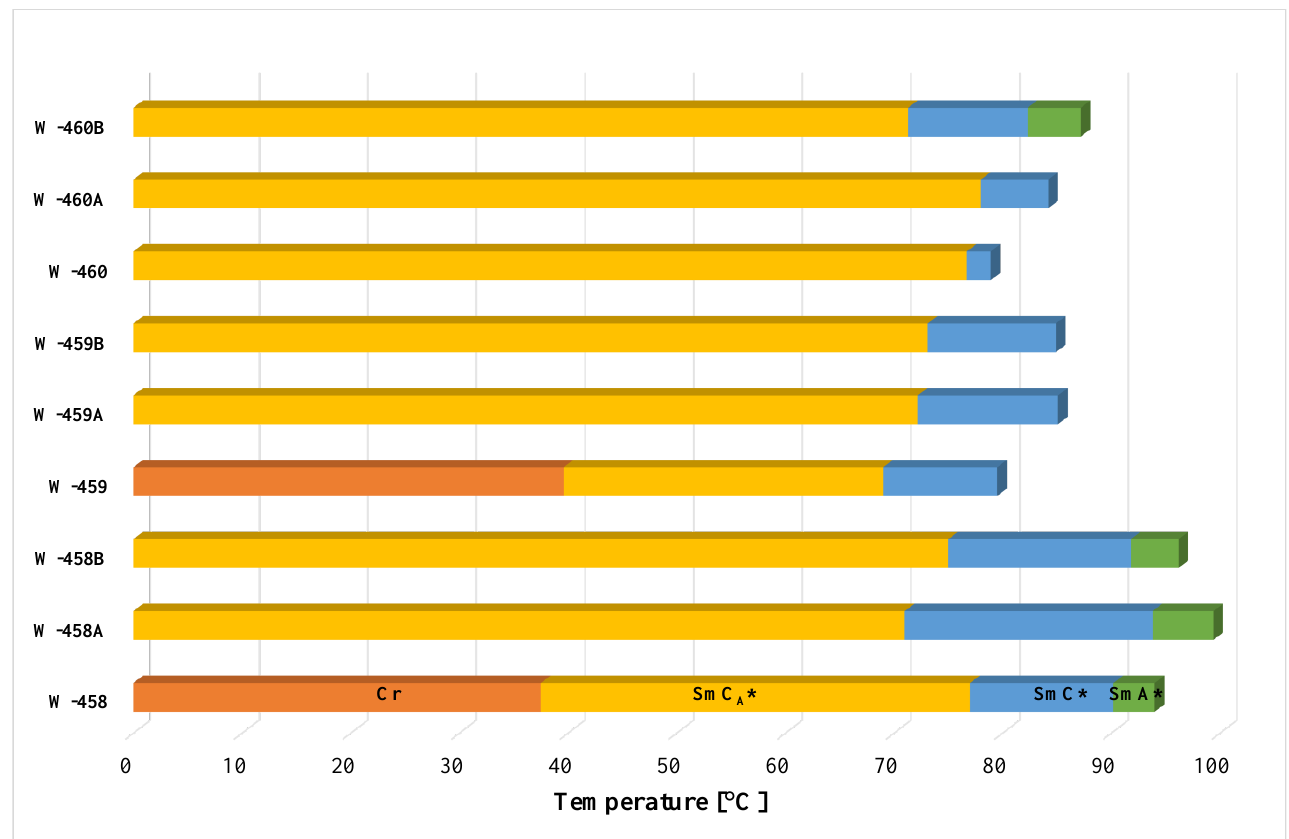
Figure 5. Comparing the temperature ranges of the phase transitions from DSC measurements for the base mixtures and the doped mixtures. (“*” means that the phase is observed). All doped mixtures have the antiferroelectric phase (SmC A *) in a very broad temperature range. The antiferroelectric phase range exceeds 70 °C for each of the doped mixtures. The broadest range of this phase is shown by the mixtures W-458B and W-460A doped with the racemic mixtures with the direct SmC A -Iso phase transition with the acro- nyms 3.HF (R,S) and 4.HF (R,S) . The ferroelectric phase (SmC*) is present in all doped mixtures in a medium or a broad temperature range. The broadest range of this phase is shown by the mixtures W-458A and W-458B (23 and 17 degrees Celsius, respectively). The smectic A* phase occurs in a short temperature range in the mixtures W-458A , W-458B and W-460B .